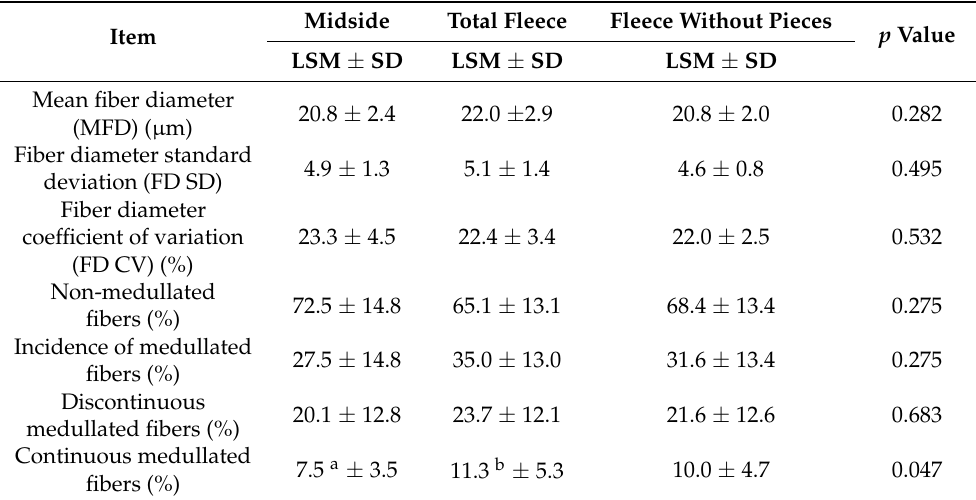
Table 4. Wool quality characteristics for the midside, total fleece, and fleece without pieces. Item